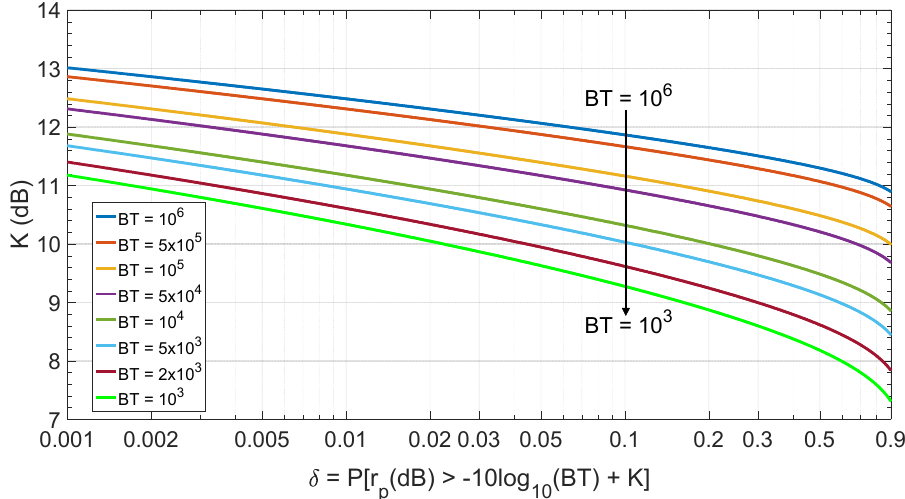
8 of 25 Figure 3. Probability of the event {(cid:1870) > (cid:1870) (cid:3012) } , (cid:1870) (cid:3012) given by Equation (11), versus (cid:1837) in dB. From Equation (11), the Rayleigh CDF of (cid:1870) results: (cid:1832)((cid:1870) (cid:3012) ) = 1 − (cid:1857) (cid:2879)(cid:2869)(cid:2868) (cid:3116).(cid:3117)∙(cid:3260) (12) Hereafter we will assume (cid:1828)(cid:1846) ≫ 1 and in the sidelobes region (i.e., for |(cid:2025) (cid:3021)(cid:3045)(cid:3048)(cid:3032) | ≅ 0 ) the PSL, i.e., (cid:1870) (cid:3043) ≝ max{(cid:1870) (cid:3012) } , can be defined as the one having a prescribed probability (hereafter named 1 − (cid:2012) ) of not being exceeded in the whole sidelobe region of the ACF (with about (cid:1840) (cid:3007) ≅ (cid:1828)(cid:1846) sidelobes). Outside the main lobe region, the CDF of the maximum sidelobe (cid:1870) (cid:3043) , Equation (12), becomes (cid:1832) (cid:3043) ((cid:1870) (cid:3012) ) = [(cid:1832)((cid:1870) (cid:3012) )] (cid:3015) (cid:3291) = (cid:3427)1 − (cid:1857) (cid:2879)(cid:2869)(cid:2868) (cid:3116).(cid:3117)∙(cid:3260) (cid:3431) (cid:3015) (cid:3291) (13) where (cid:1840) (cid:3017) = (cid:1861)(cid:1866)(cid:1872) (cid:4676) (cid:3003)(cid:3021) (cid:2870) − 1(cid:4677) . For (cid:1837) = 0, (cid:1832) (cid:3043) ((cid:1870) (cid:2868) ) = [1 − (cid:1857) (cid:2879)(cid:2869) ] (cid:3015) (cid:3291) ≅ 0 being (cid:1840) (cid:3043) ≫ 1 ((cid:1828)(cid:1846) ≫ 1) and the probability that (cid:1870) (cid:3043) exceeds −10 ∙ (cid:1864)(cid:1867)(cid:1859) (cid:2869)(cid:2868) ((cid:1828)(cid:1846)) is very close to the unit. Posing (cid:1832) (cid:3043) ((cid:1870) (cid:3012) ) = 1 − (cid:2012) and solving Equation (13), the corresponding value of (cid:1837) (in dB) is